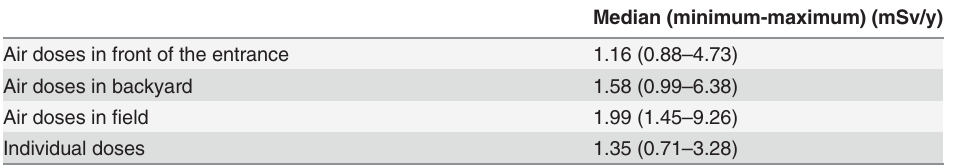
Median (minimum-maximum) (mSv/y)